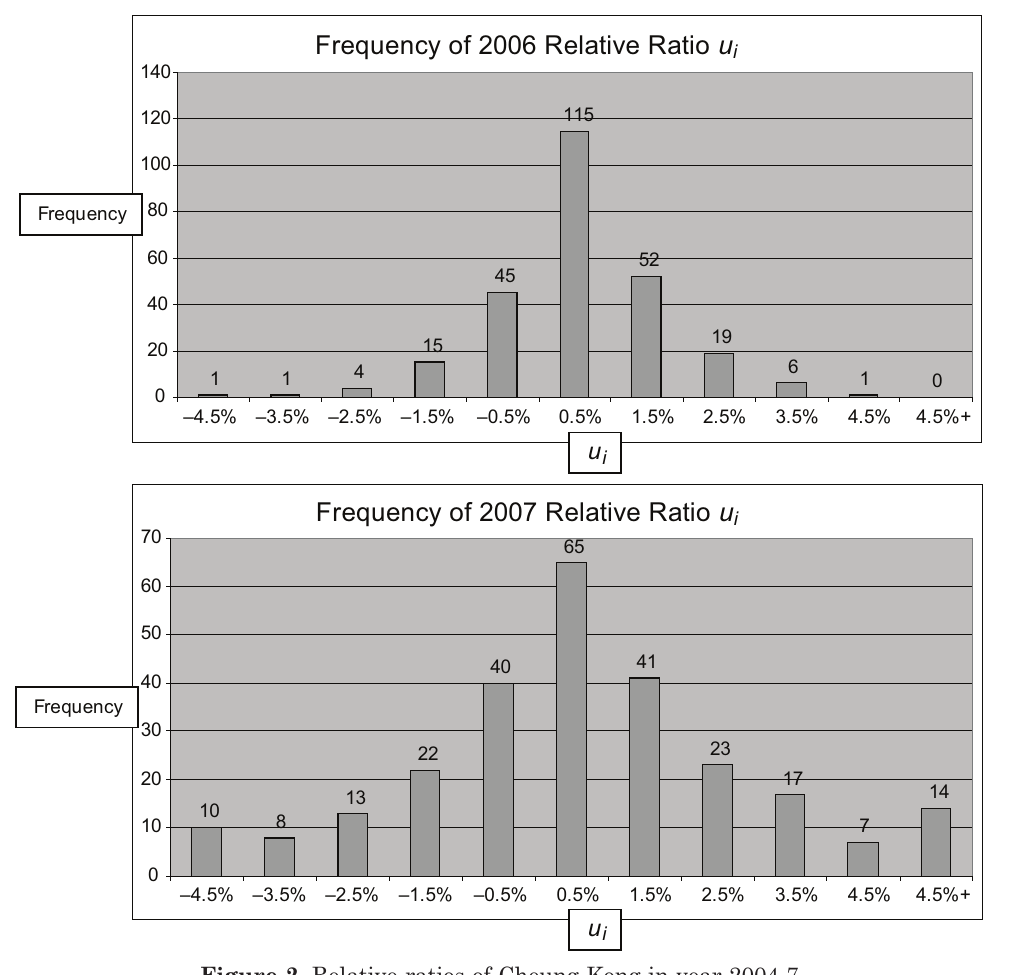
figure 2. relative ratios of Cheung Kong in year 2004-7